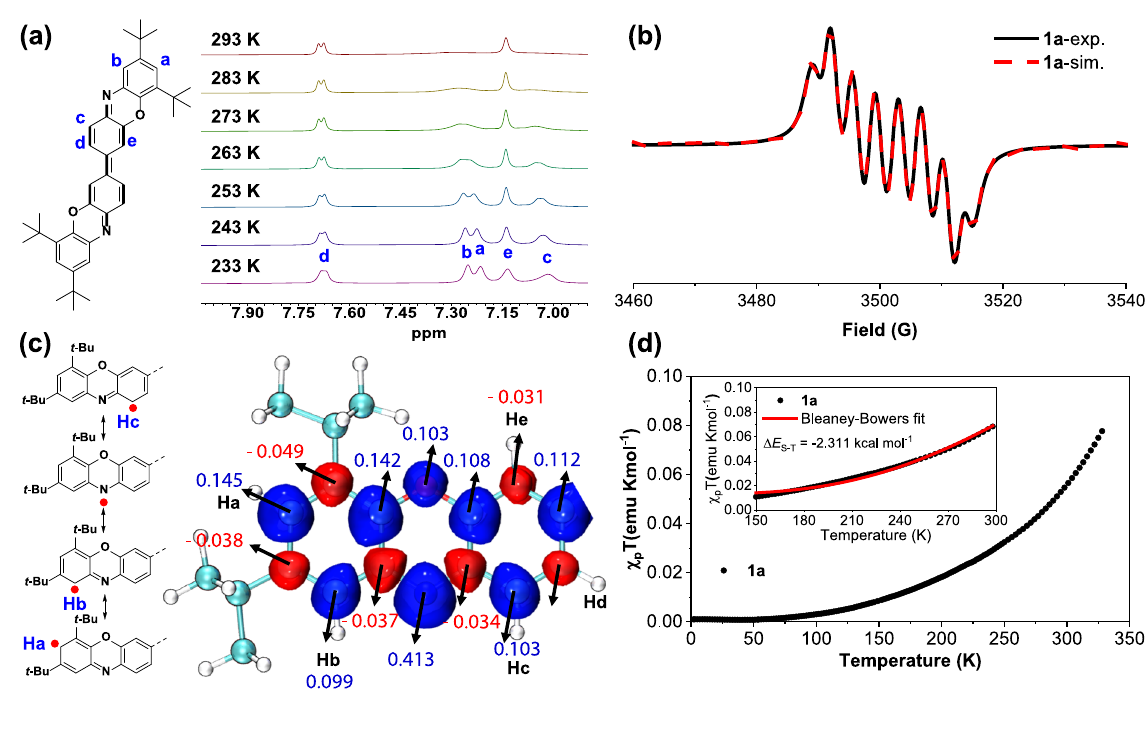
Fig. 5 Magnetic properties of 1a. a VT 1 H NMR spectra (aromatic region) of 1a in CD 2 Cl 2 and assignment of all aromatic protons. b EPR spectrum of 1a in CH 2 Cl 2 solution measured at room temperature and its simulation. c The typical resonance forms of 1a and its calculated spin density distributions. For clarity, only one-half of 1a is shown. d χ T – T plot for the powder of 1a in SQUID measurement. The inset shows the best fi tting plots (red solid line) obtained with the Bleaney-Bowers equation. χ p = χ mol - χ d , χ d : diamagnetic susceptibility ( χ d of 1a : ~ − 425 × 10 − 6 emu mol − 1